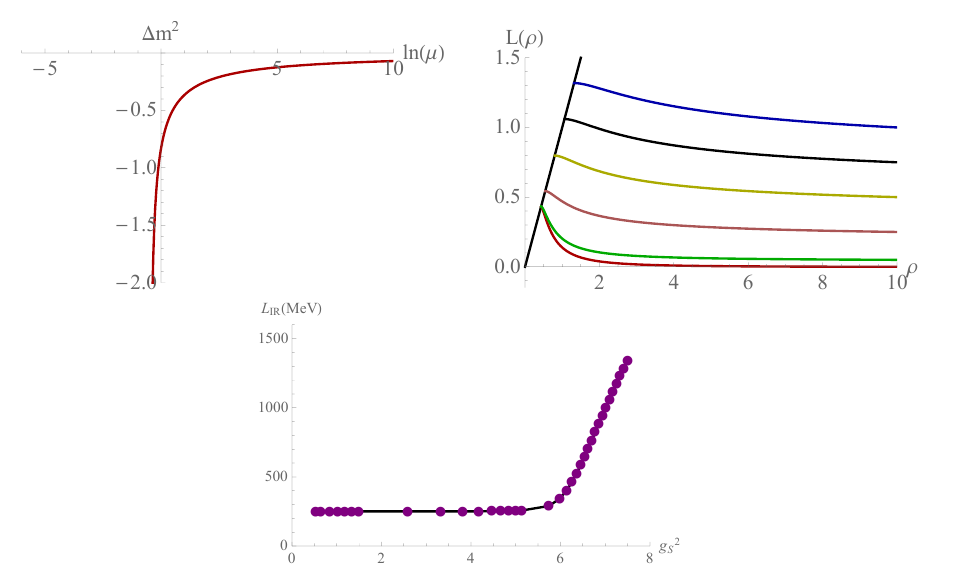
Figure 1. Top left: the running of the mass in the Dynamic AdS / QCD theory for 2 flavour SU(3) QCD. Top right: the resulting vacuum L ( ⇢ ) profiles which asymptote at large ⇢ to the quark mass. Bottom: the IR quark mass against NJL coupling in two flavour QCD using the solutions above and